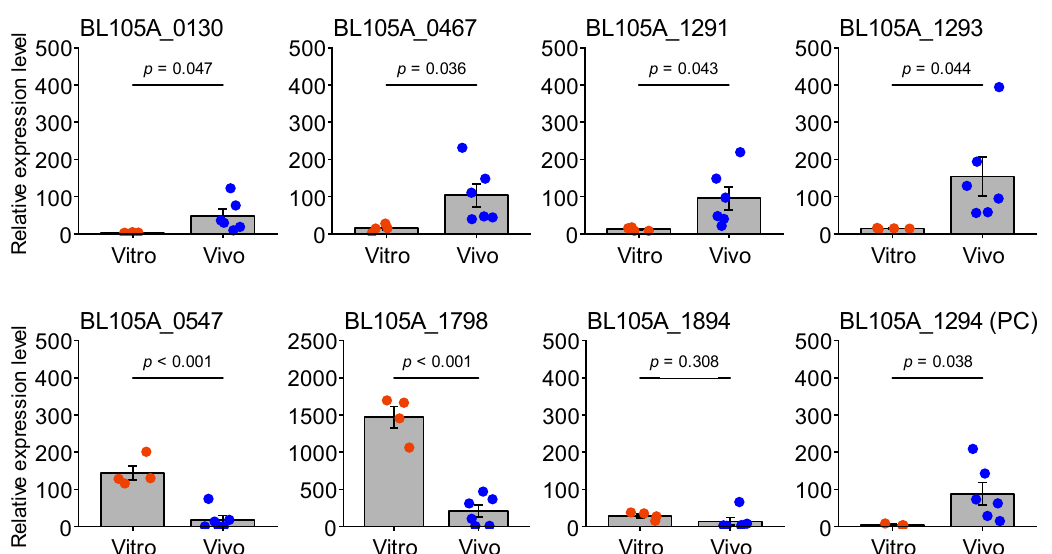
Figure 4. In vitro and in vivo relative expression levels of the genes identified by R-IVET. BL105A_1294 (encoding β -fructofuranosidase (glycoside hydrolase family 32)) was used as a positive control (PC) in qRT-PCR analysis, while the other genes were used to verify in vivo-induced expression in the cecum. BL105A_1946 ( rnpA ) was used as a reference gene. Data obtained from in vitro ( n = 4) and in vivo ( n = 6) conditions are expressed as the mean ± standard deviation together with each data plot. After testing the equality of variance by the F -test, Student’s or Welch two-tailed t -tests were used to evaluate statistical significance. p -values of the t -tests are also indicated in each panel and p < 0.05 was considered as statistically significant.